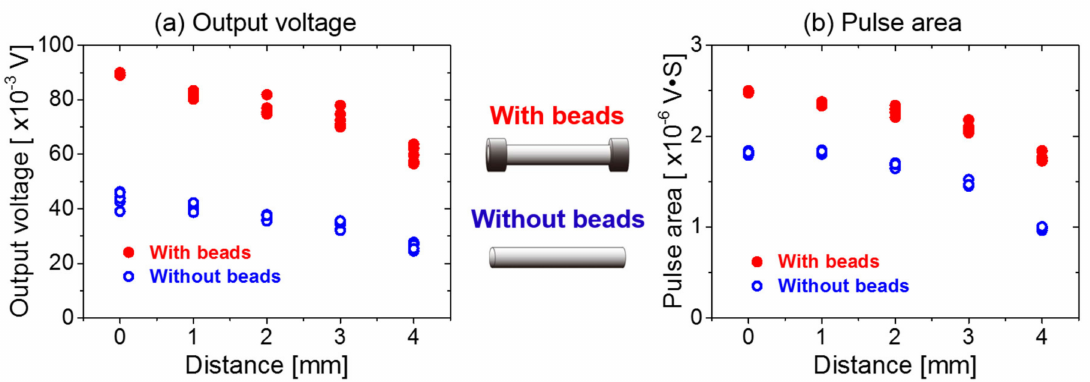
Figure 9. Experimental results of the relationship between the amplitude and area of the Wiegand pulse and the position of the pickup coil, displaying: ( a ) output voltage and ( b ) pulse